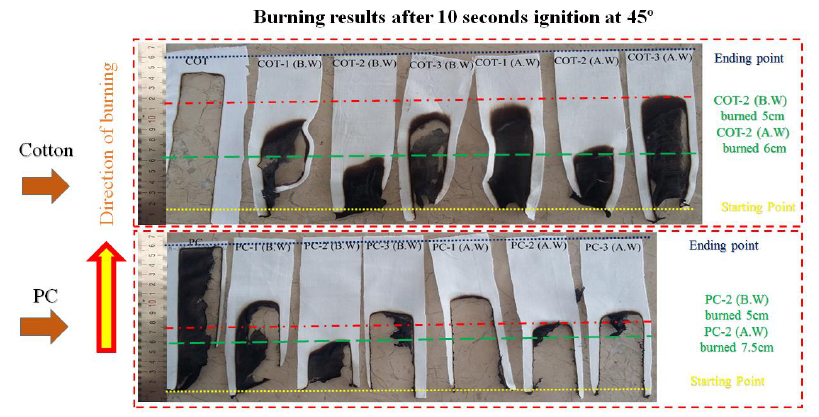
Figure 5. Flammability test for COT and PC blend fabrics BW and AW for 10 s.